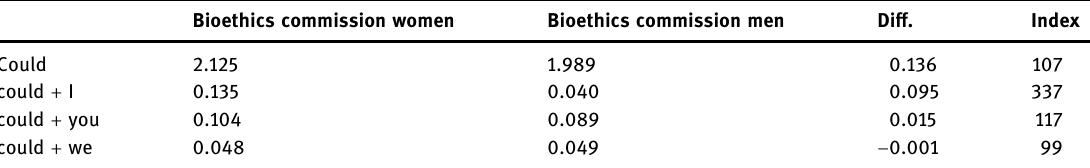
Bioethics commission women